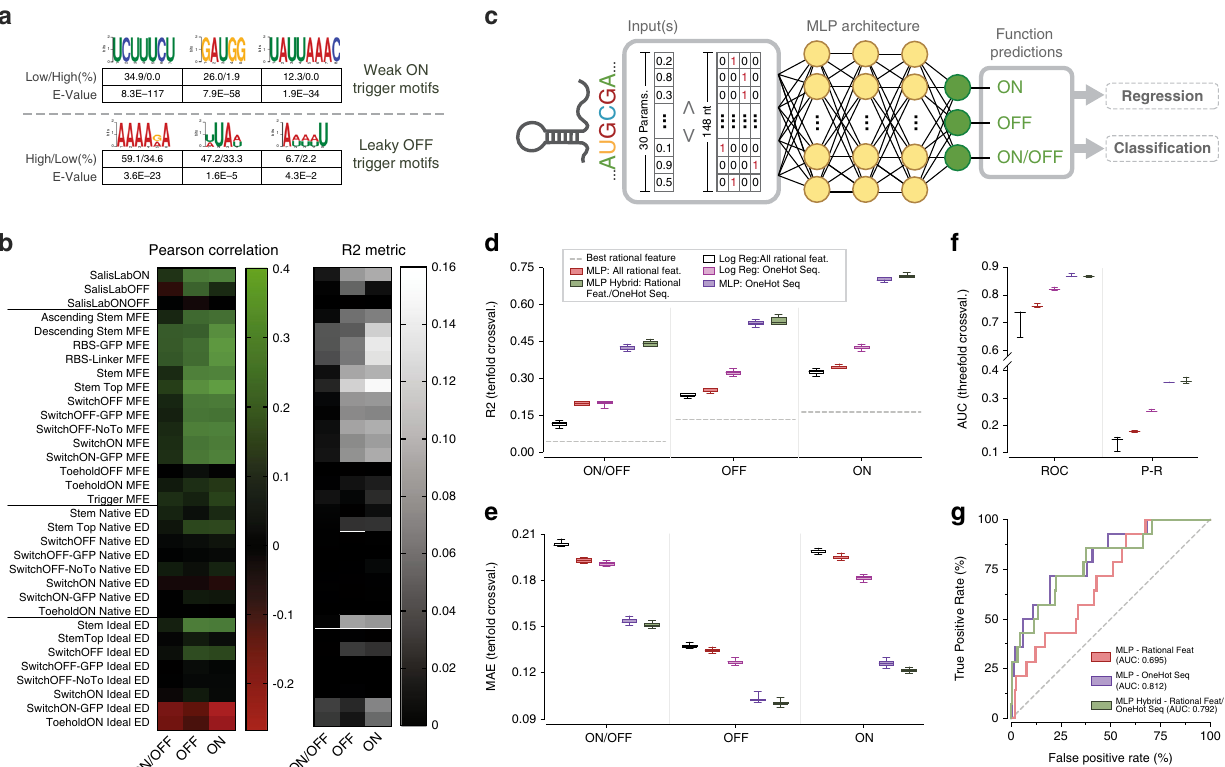
Fig. 3 Analysis of toehold-switch performance using multilayer perceptron (MLP) models. a Sequence logos for k-mer motifs discovered to be disproportionately represented in weakly induced switches (low ON) and leaky switches (high OFF), functional proportions, and E -values. b The Pearson correlation (left, |max| = 0.4) and R 2 metric (right, |max| = 0.16) for 30 state-of-the-art thermodynamic features and obtained RBS Calculator v2.1 outputs. c Base architecture of investigated MLP models, featuring three fully connected layers. For training in regression mode, three different outputs were predicted (ON, OFF, ON/OFF), whereas for classi fi cation training, only a single binary output based on ON/OFF (threshold at 0.7) was predicted. d Box- and-whisker plots for R 2 between experimental and regression-based predictions for best-performing rational features, logistic regression models and MLPs using tenfold cross-validation (test sets randomly selected from quality control process #2, QC2 in Supplementary Fig. S13 and Supplementary Table 1). e Box-and-whisker- plots for mean absolute error (MAE) between experimental and predicted values for these same models. f Box- and-whisker plots for the area under the curve (AUC) of the receiver – operator curve (ROC) and the precision-recall curve (P – R) in classi fi cation-mode predictions compared to experimental values using threefold cross-validation (test sets randomly selected from quality control process #2, QC2 in Supplementary Fig. S13 and Supplementary Table 1). In both regression and classi fi cation, the one-hot encoded sequence MLP delivered top-in-class performance without using pre-computed thermodynamic or kinetic metrics. g ROC curves of pre-trained MLP classi fi cation models validated with an unseen 168-sequence external dataset from Green et al. 2 . For all box-and-whisker plots, the horizontal line indicates the median, box edges are at the 25th and 75th percentiles, and whiskers indicate the smaller of either 1.5 × IQR or max/min. All source data are provided as a Source Data fi